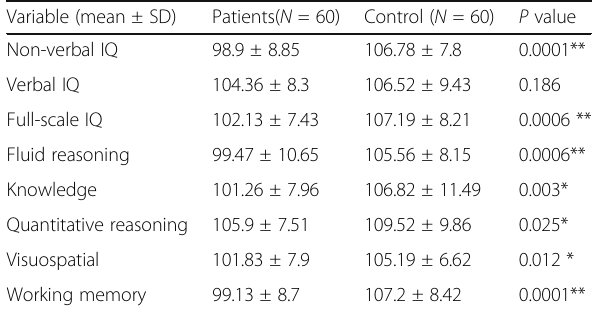
Table 2 Cognitive function parameters in studied groups